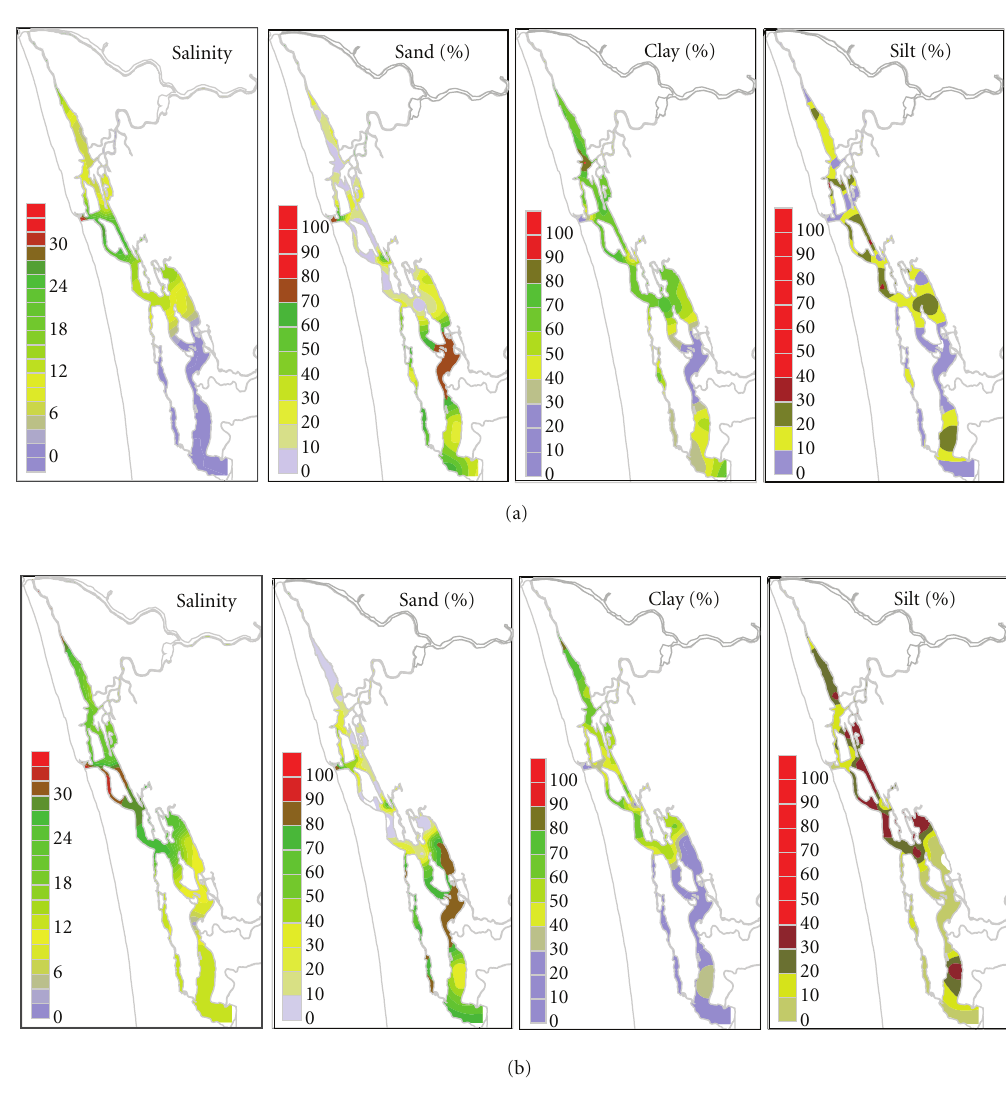
Figure 2: Salinity, sand, slit, clay during monsoon (a) and premonsoon